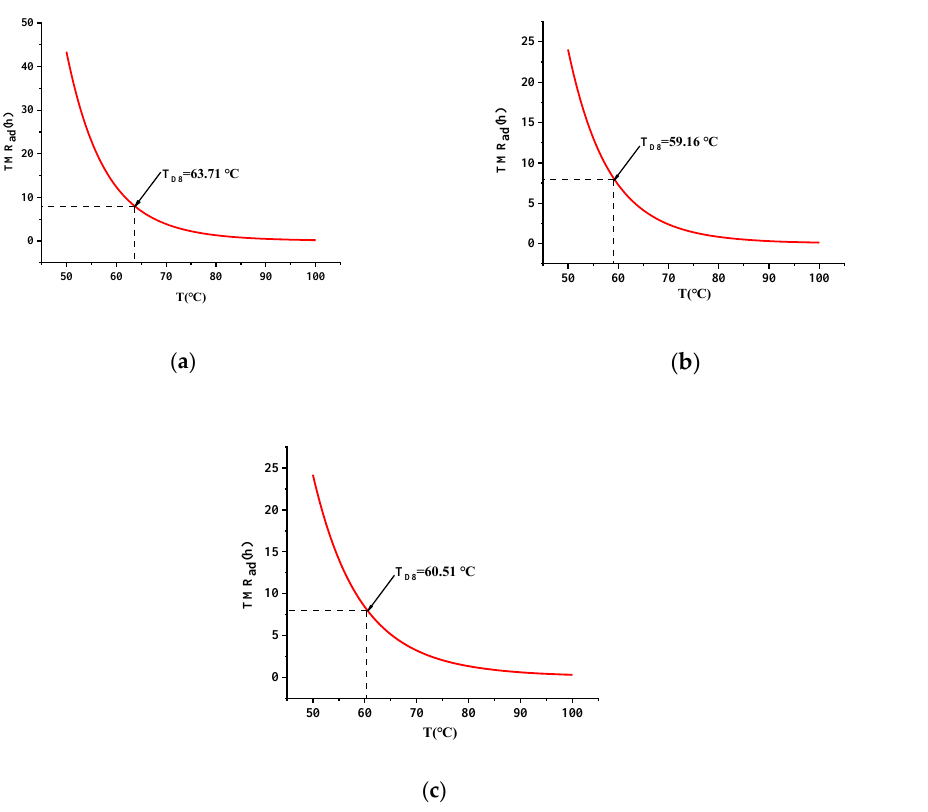
Figure 8. TMR ad -temperature curves of TBPTMH ( a ) and mixtures with H 2 SO 4 and NaOH ( b , c ). According to the evaluation criteria of the possibility of accidents, T D8 (the temper- ature corresponding to TMR ad = 8 h) was chosen in this paper to simulate the real oper- ating temperature. The T D8 of TBPTMH is 63.71 °C, so the temperature should be con- trolled below 63.71 °C during the actual operation.